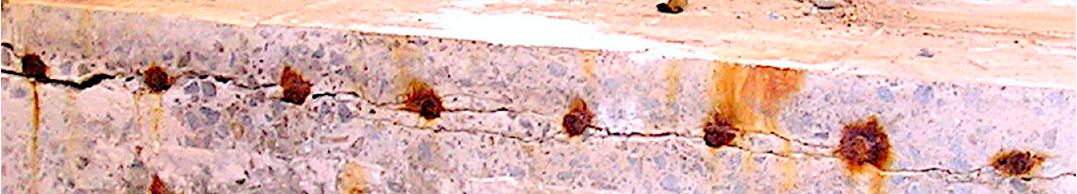
Figure 3. Cut cross-section in 2009 of a 450 mm thick deck slab (cover 40 mm) exposed since the 1930s in the Newcastle Harbour marine atmosphere, showing delamination crack passing through the bottom of the 16 mm diameter bars. © R.E. Melchers 2009.